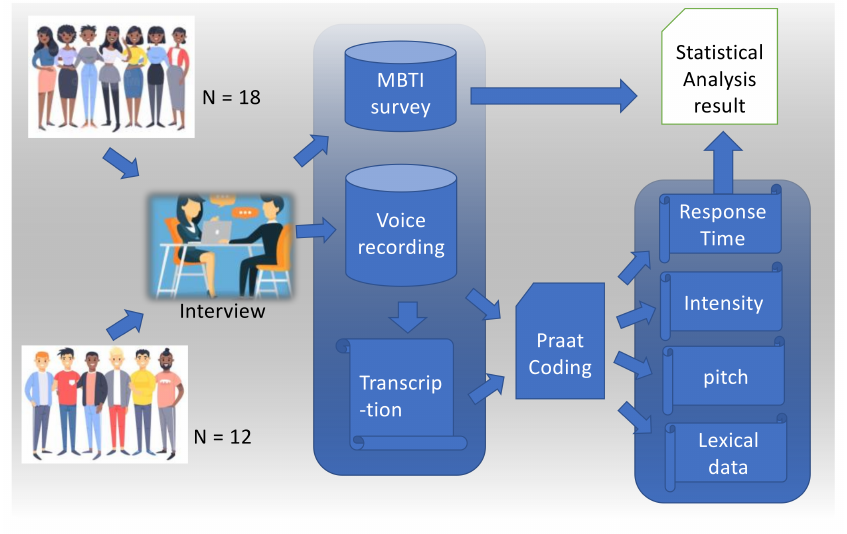
Figure 2. Data collection and processing